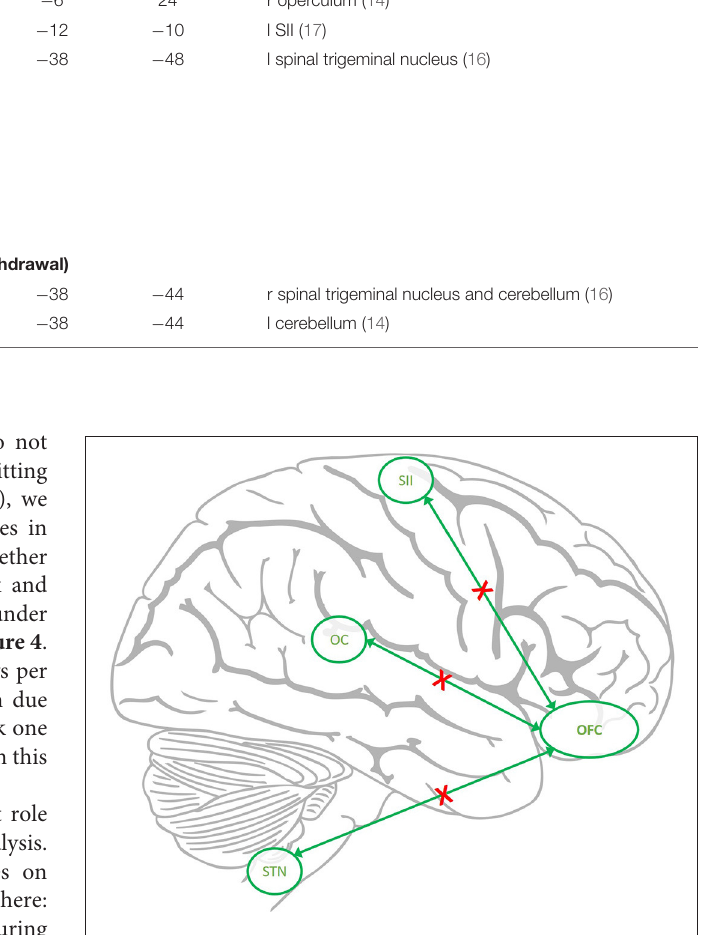
TABLE 3 | Alteration in neuronal responses to nociception and in functional connectivity from OFC in MOH patients and controls. Cluster size (voxel with 2 mm 3 ) T -value MNI coordinate Region (reference used for small volume correction) x y z Neuronal activity in patients (after > before drug withdrawal) 54 4.52 36 − 6 24 r operculum (14) 77 4.28 − 42 − 12 − 10 l SII (17) 4.05 − 4 − 38 − 48 l spinal trigeminal nucleus (16)